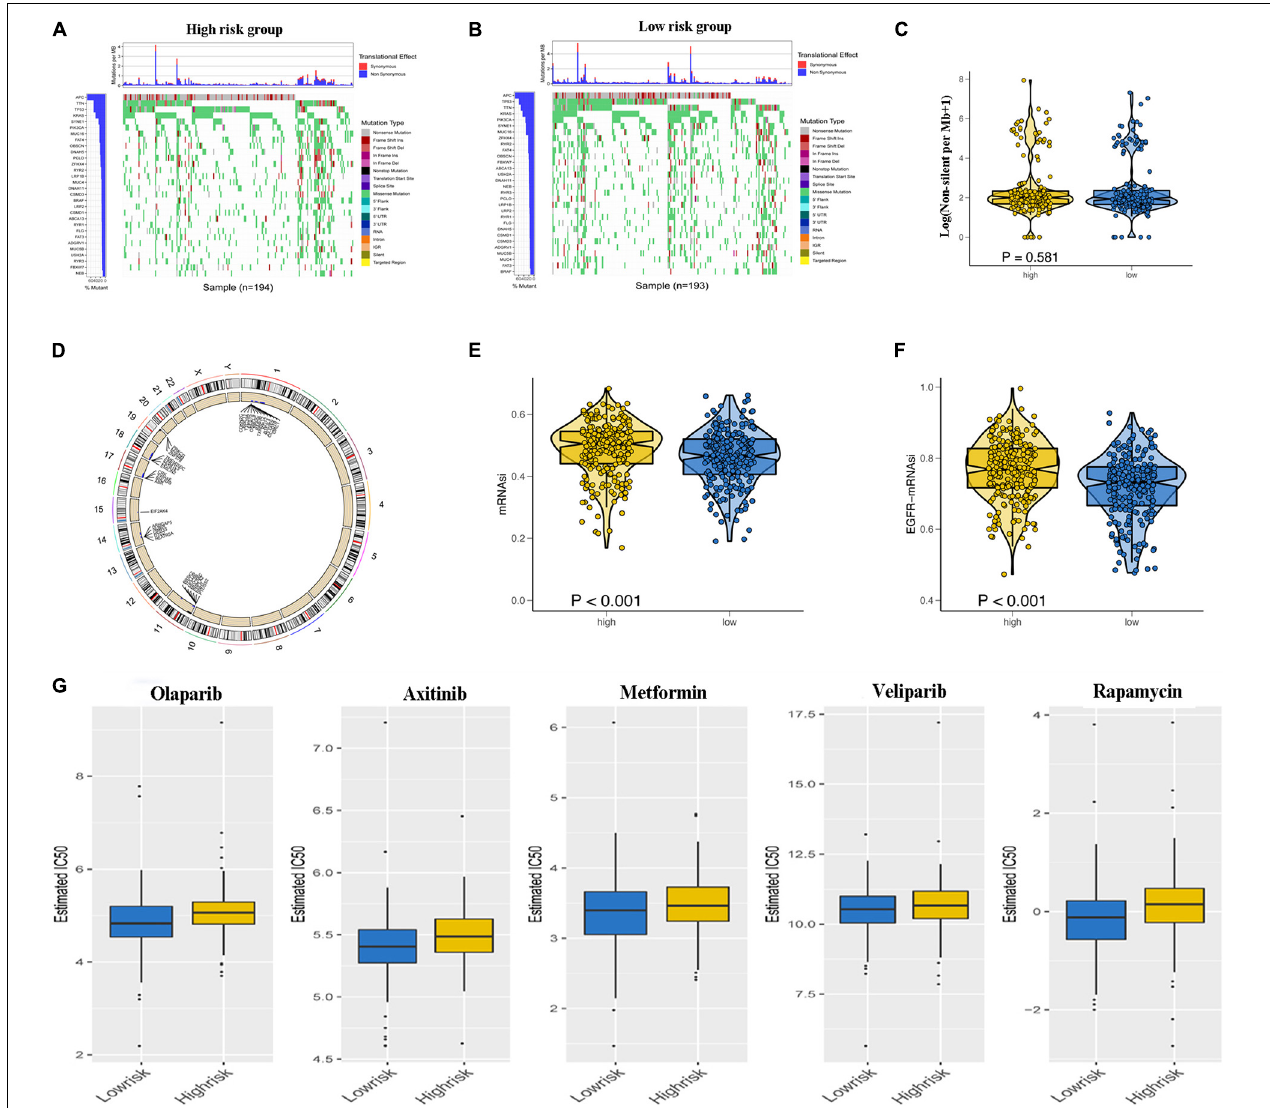
FIGURE 7 | Relationship of glycolysis-related gene (GRG) risk group with tumor mutation burden, copy number variation, tumor stemness, and chemotherapy response. (A,B) Waterfall plots demonstrating the higher frequency of mutated genes in the high-risk and low-risk groups. (C) Difference in total tumor mutation burden in low- and high-risk colon adenocarcinoma (COAD) patients. (D) Distinct genes with different copy number variations due to gains or loss of nucleotides mainly on chromosomes 1, 11, 14, 17, 18, and 19 (E,F) . Difference in tumor stemness by the mRNAsi (E) and EGFR mRNAsi (F) . (G) Estimated IC50 indicating the efficiency of chemotherapy to GRGs in low- and high-risk patients of olaparib, veliparib, axitinib, metformin, and